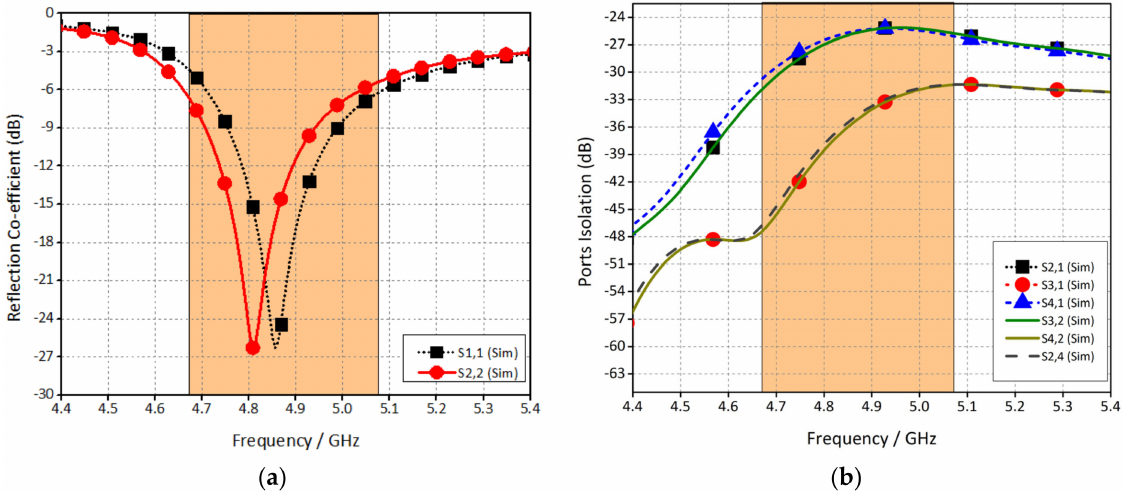
Figure 4. Simulated S-parameters of proposed Antenna ( a ) Reflection Coefficient ( b ) Ports